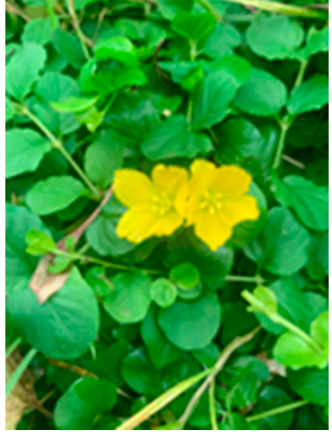
Figure 1. Lysimachia nummularia L.